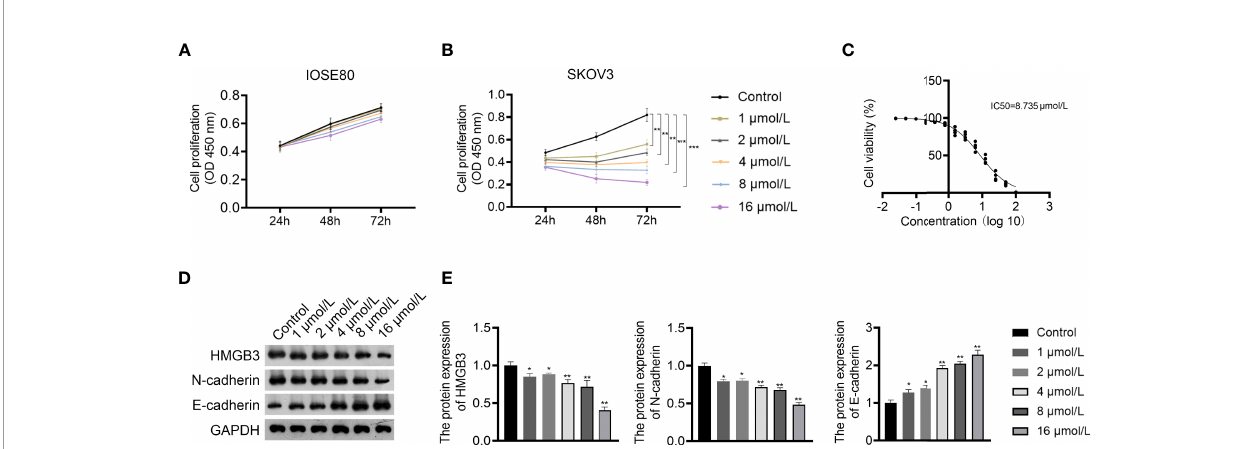
FIGURE 2 | Glaucocalyxin A (GLA) dose-dependently inhibited proliferation, epithelial-mesenchymal transition (EMT), and HMGB3 expression in EOC cells. (A, B) The proliferation of IOSE80 and SKOV3 cells was measured by CCK-8 assay. (C) The IC50 value of GLA was determined by a proliferation curve at 48 h post- treatment. (D, E) The protein levels of HMGB3 and EMT-related biomarkers (E-cadherin and N-cadherin) in SKOV cells were detected by western blotting. EOC cells were treated with 1, 2, 4, 8, and 16 m mol/L GLA, respectively. *P <0.05 and **P <0.01 vs. control..